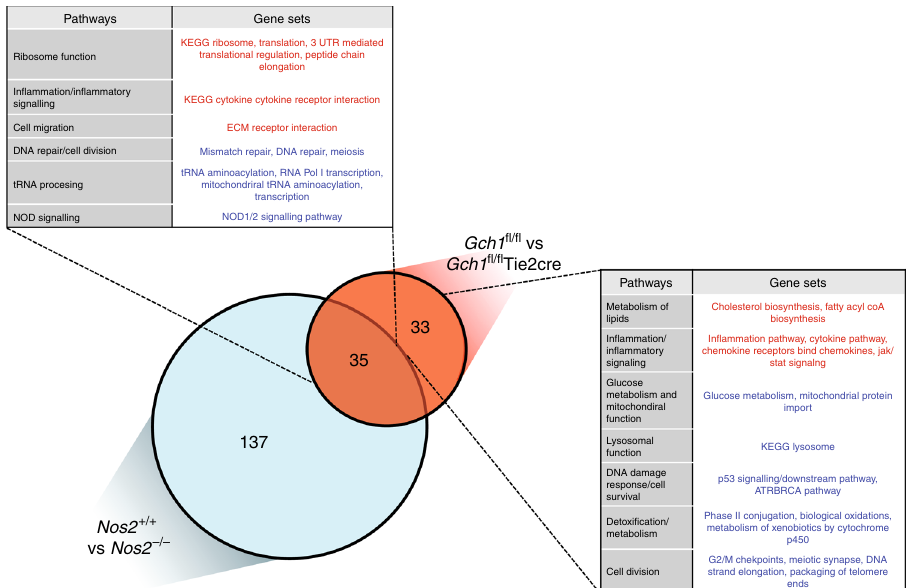
Fig. 7 GSEA using curated pathways identi fi es shared and unique genesets. Enriched gene sets in BCG infected macrophages, identi fi ed by Preranked GSEA (MSigDb, C2 CP annotations set). To determine how far regulated geneset were shared between the Gch1 and Nos2 knockout macrophages or unique to the loss of Gch1 the gene set lists passing p < 0.005, FDR q < 0.1 in both analyses were compared and key genesets were are highlighted in the